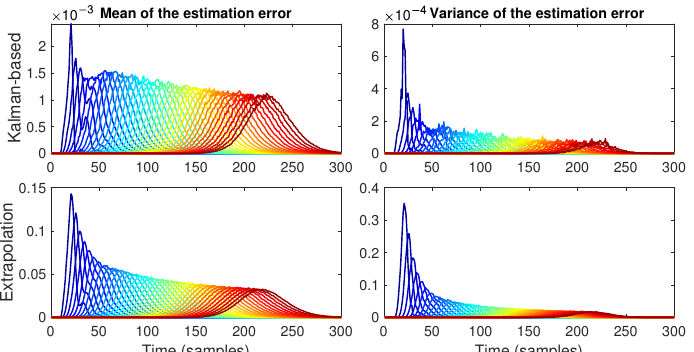
( k ) and variance σ 2 ( k ) of the estimation error for distance-dependent p Figure 21. Mean µ ε ε i i The Kalman-based strategy achieves a lower mean and variance for the estimation error in comparison to the extrapolation strategy.